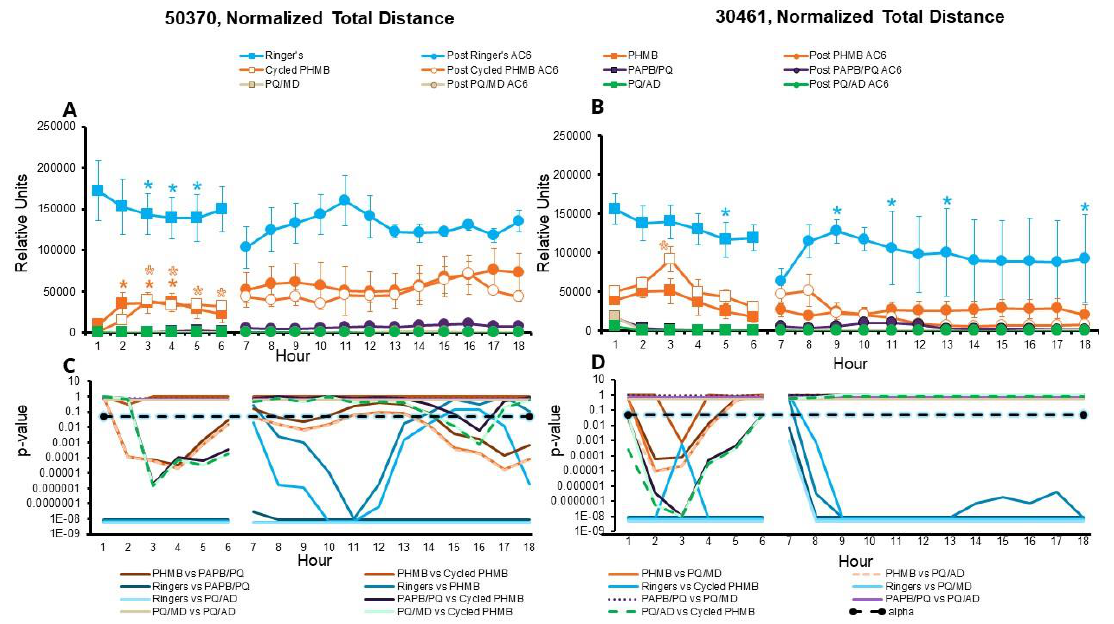
Figure 4. Surviving Acanthamoebae recover total distance traveled after disinfection. Amoebae were disinfected or put in one-quarter Ringer’s solution for the first 6 h, followed by AC6 media for the following 12 h (total 18 h). Normalized total distance is presented as mean ± SE. ( A ) Acanthamoeba castellanii (ATCC 50370), and ( B ) Acanthamoeba polyphaga (ATCC 30461). Relative units: average total distance moved by each amoeba in the field of view, multiplied by the number of moving amoebae, resulting in the total number of microns moved by all amoebae. * p < 0.05 vs. each condition’s own baseline (either hour 1 or hour 7 for the CLC or AC6 conditions, respectively). Statistical comparisons between conditions are represented in ( C ) p -values for ( A ), and ( D ) p -values for ( B ). Alpha was set at 0.05. n = 3/group.